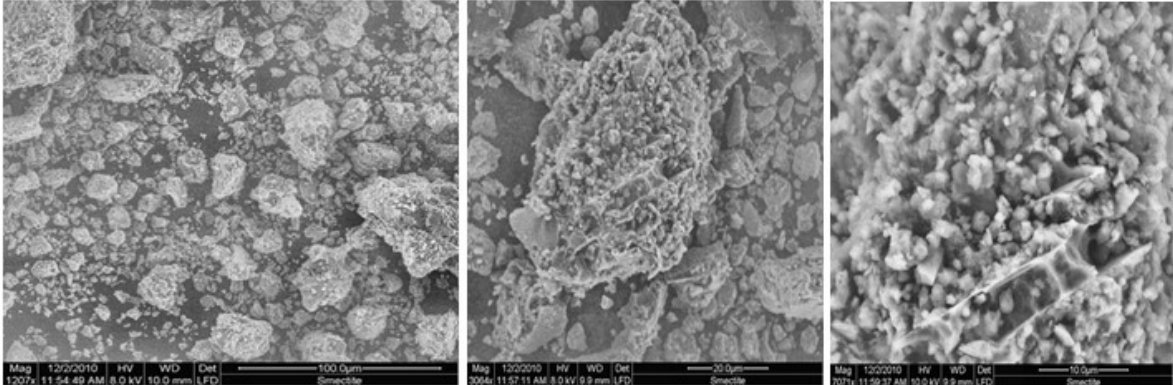
Fig.2. SEM micrograph of the natural